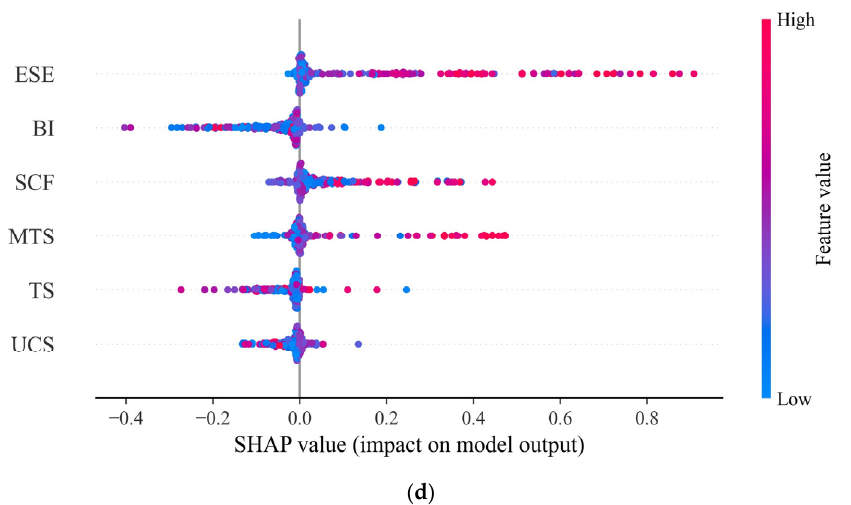
Figure 12. SHAP to interpret HGBT for the prediction of rockburst with different intensity levels: ( a ) None; ( b ) Light; ( c ) Moderate; ( d ) Strong.